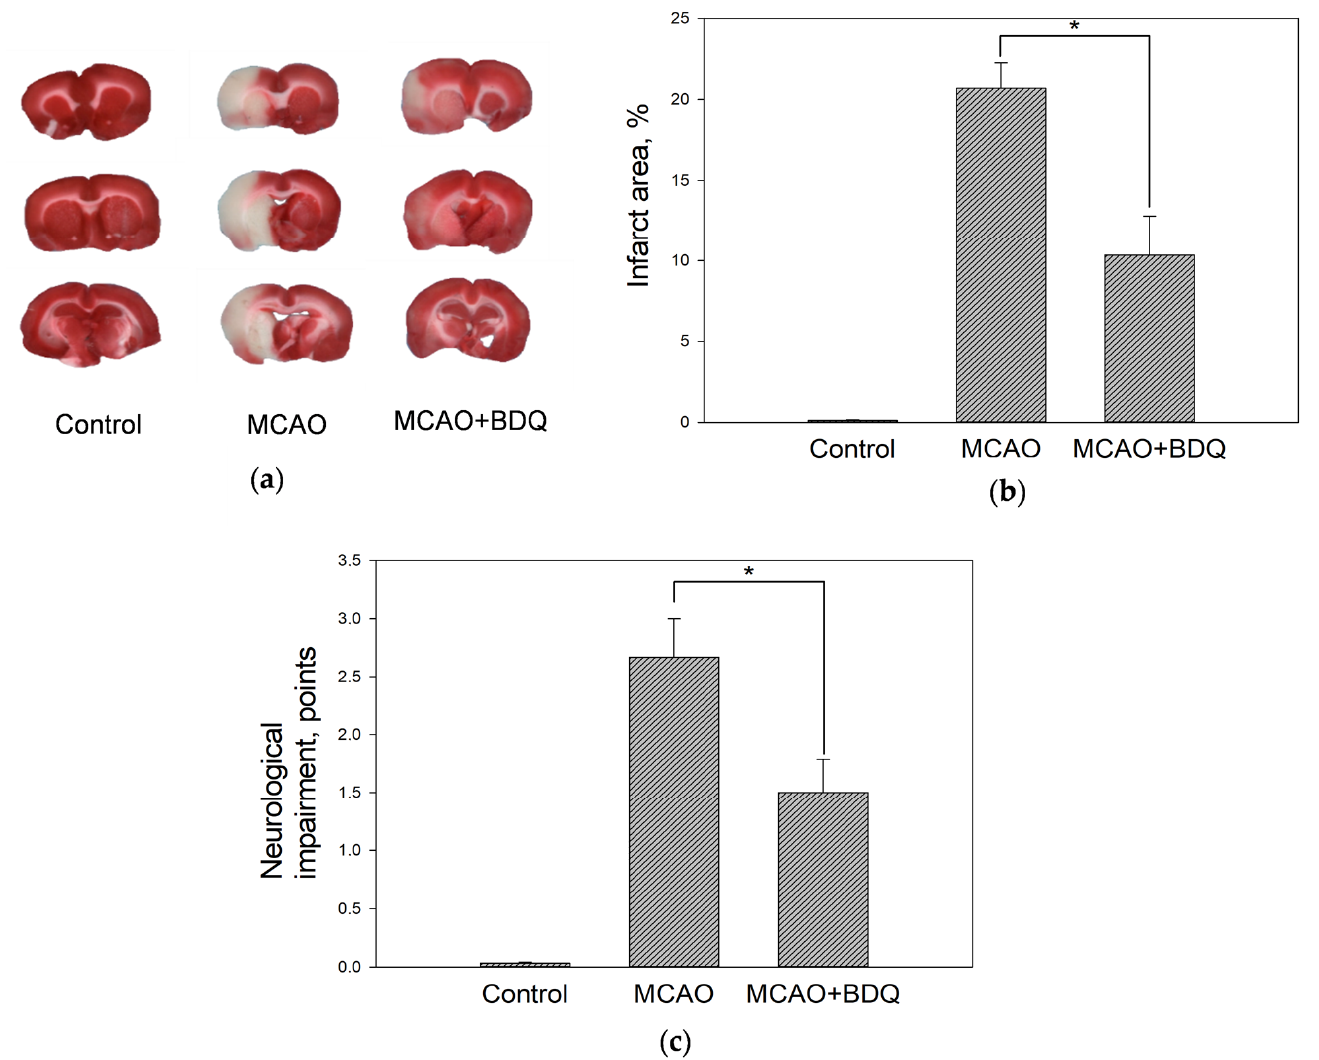
Figure 1. The effect of bedaquiline (BDQ) treatment on infarct size and neurological impairment. ( a ) Representative images of 2, 3, 5 triphenyltetrazolium chloride (TTC) staining of brain slices. ( b ) The effect of 60 min middle cerebral artery occlusion (MCAO)/24 h reperfusion as well as BDQ treatment on the infarct size in TTC stained brain slices. ( c ) The effect of 60 min MCAO/24 h reperfusion as well as BDQ treatment on the neurological state of the animals. Data are presented as Mean ± SEM of 3–4 experiments on individual animals. *—Statistically significant difference ( p ≤ 0.05).